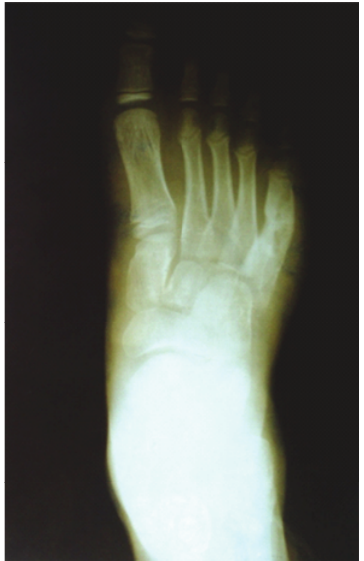
Figure 1: A radiograph of the right foot showed an eccentric lytic lesion of the cortex and the medullary space in the diaphysis of the fifth metatarsal with sclerotic margins.